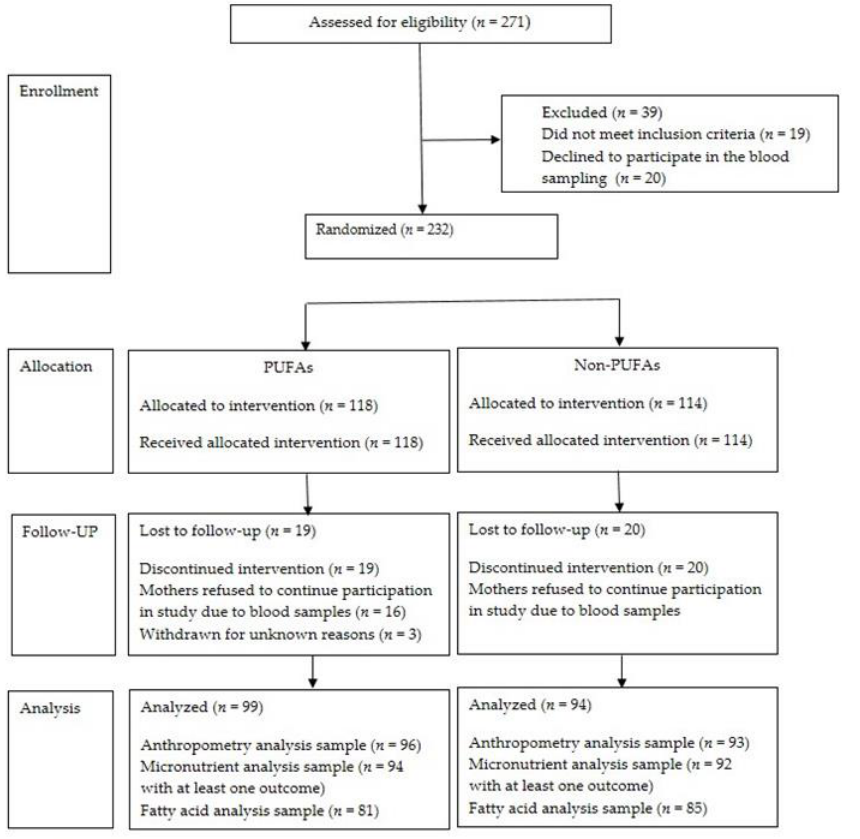
Figure 1. Flow of study subjects. Formula PUFAs contained vegetable oil (palm oil, coconut, soy and high oleic sunflower oils). DHA from fish origin, Linoleic Acid, Alpha-Linolenic Acid. Morbidity information included diarrhea and acute respiratory infection. PUFAs: Milk-based infant formula with polyunsaturated fatty acids, Non-PUFAs: Formula with micronutrients only non polyunsaturated fatty acids.